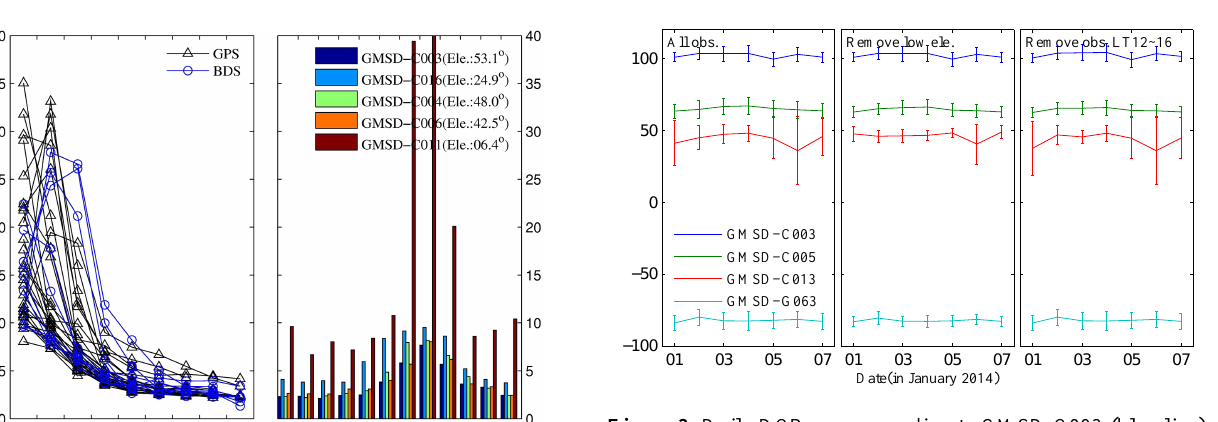
Figure 3. Daily DCBs corresponding to GMSD-C003 (blue line), GMSD-C005 (green line), GMSD-C013 (red line), and GMSD- G063 (cyan line) during 1–7 January 2014. The vertical bars rep- resent for the daily standard